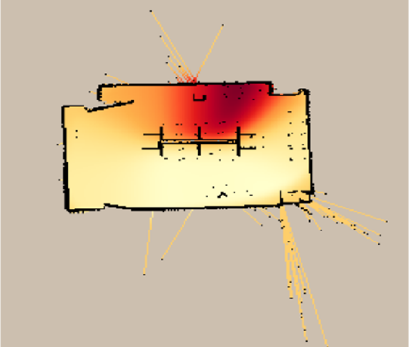
Figure 5. GDM 2D mean gas concentration map.